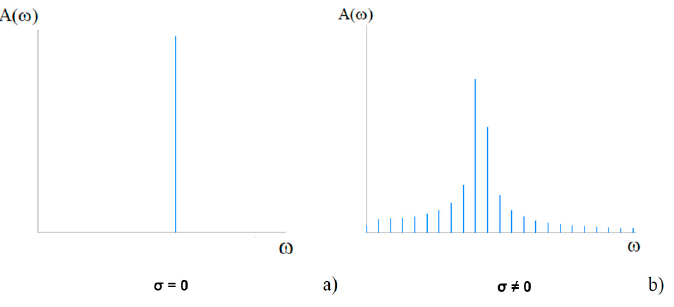
Figure 6. The DFT leakage effect. Integer ( a ) and a non-integer ( b ) sample number during one pe- riod.